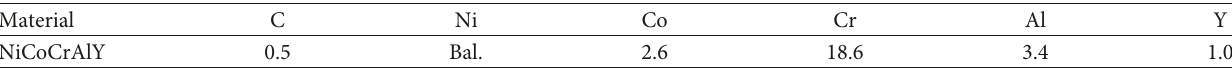
Table 2: Chemical elemental composition of NiCoCrAlY alloy powder (mass fraction, wt.%).